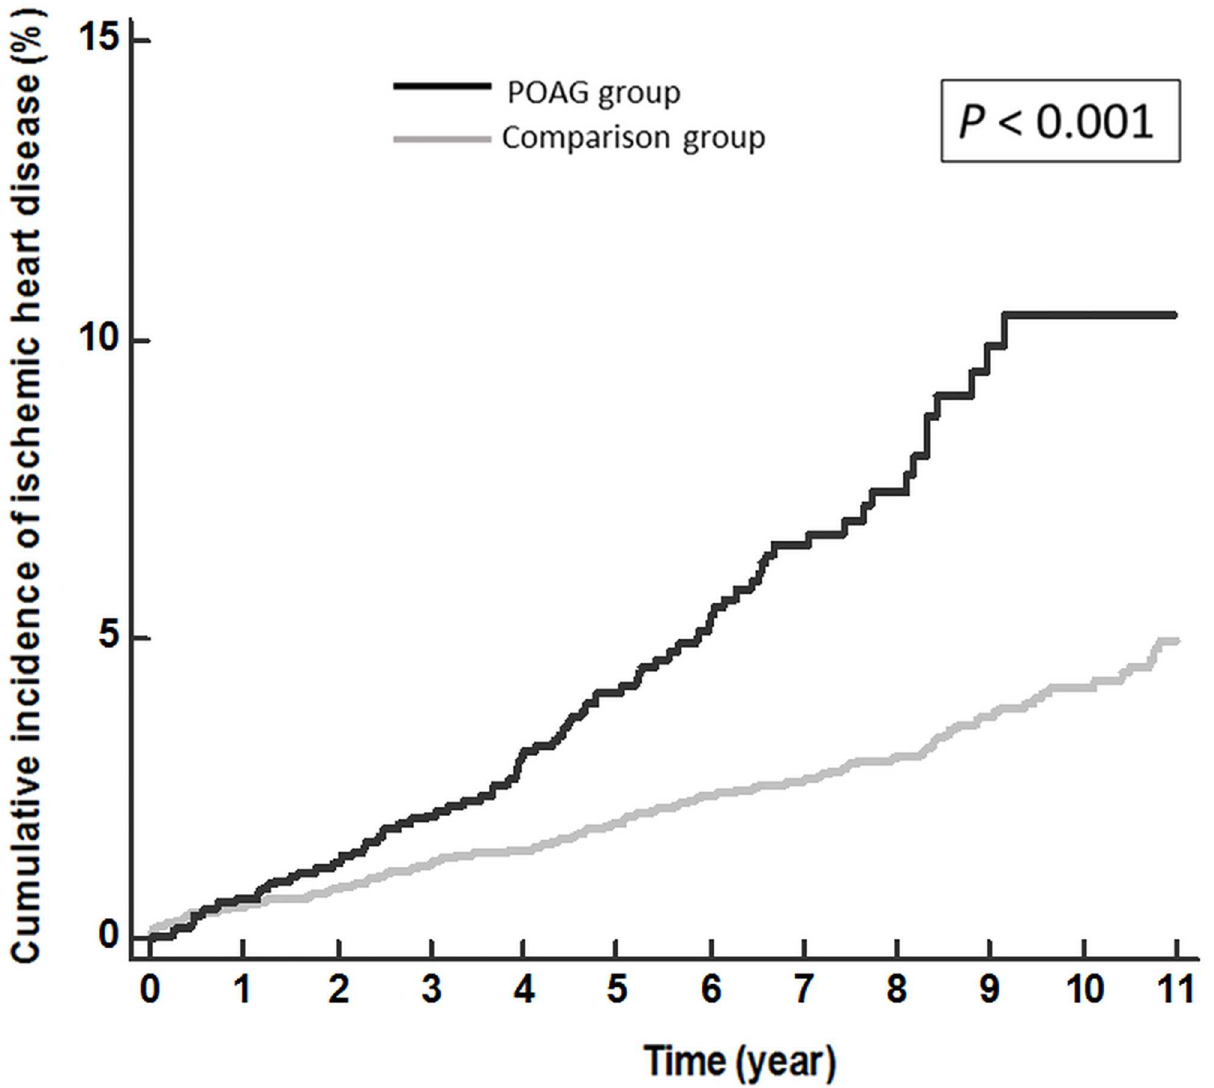
Fig 1. Kaplan-Meier curves for IHD among POAG and comparison groups. Black line represents POAG group and gray line represents comparisongroup.